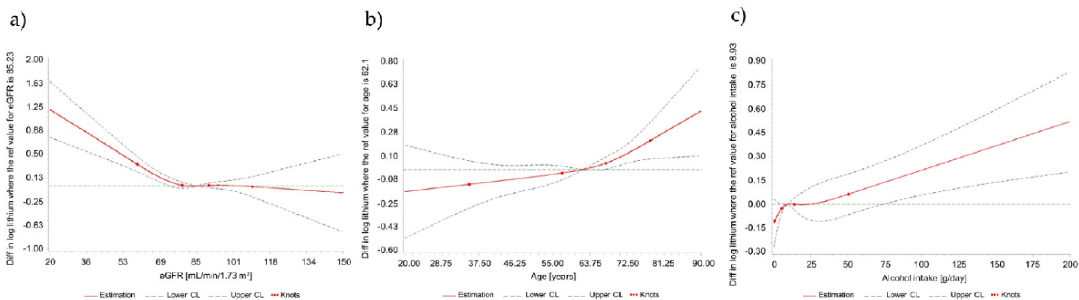
Figure 1. Association of log-transformed lithium plasma levels with eGFR, age and alcohol intake (each variable modeled individually) using RCS. Legend to the Figure: Restricted cubic splines (RCS) regression for the association of plasma lithium concentrations in 928 participants with: ( a ) estimated glomerular filtration rate (eGFR); ( b ) age; and ( c ) alcohol intake. The solid line indicates estimated differences in log lithium and dashed lines indicate 95% CI derived from RCS regression, with four knots placed at the 5th, 35th, 65th and 95th percentiles of the distribution, using the 50th percentile as a reference, of: ( a ) eGFR values; ( b ) age; and ( c ) alcohol intake. Estimated differences were adjusted for age, sex, diastolic blood pressure, eGFR, alcohol intake and smoking status. Wald p values are: ( a ) eGFR, p for nonlinearity 0.0006 and p for overall association <0.0001; ( b ) age, p for nonlinearity 0.29 and p for overall association 0.002; and ( c ) alcohol intake, p for nonlinearity 0.46 and p for overall association 0.002.